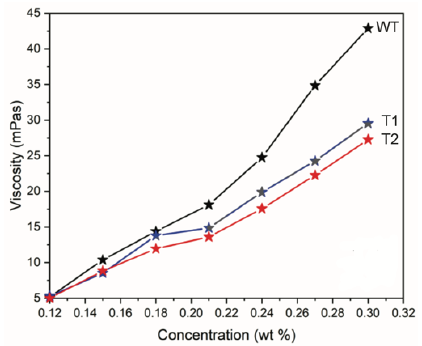
Figure 1. Viscosities as a function of suspension concentration for different CNFs from T1 and T2 compared to WT.